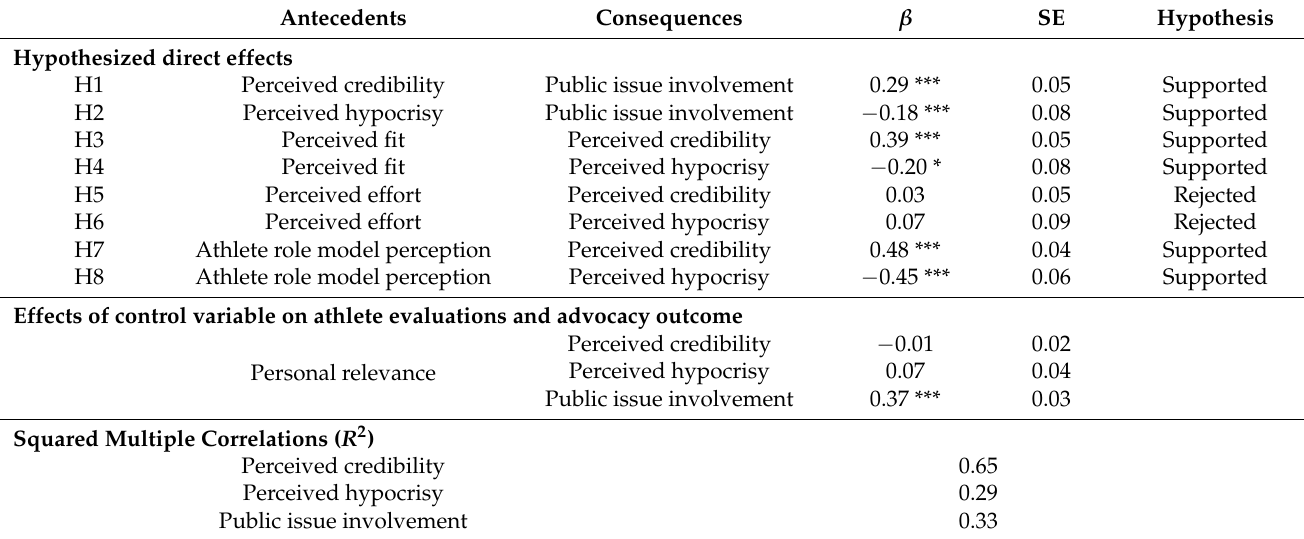
Table 4. Standardized results of the structural model (Sample B: n =